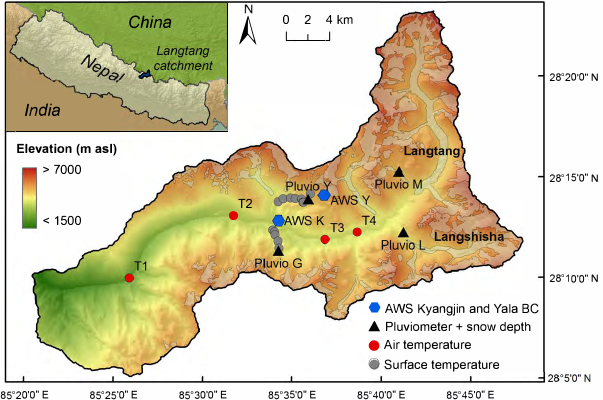
Figure 1. Study area with the locations of the in situ observations. Langtang and Langshisha refer to the two main glaciers in the upper Langtang